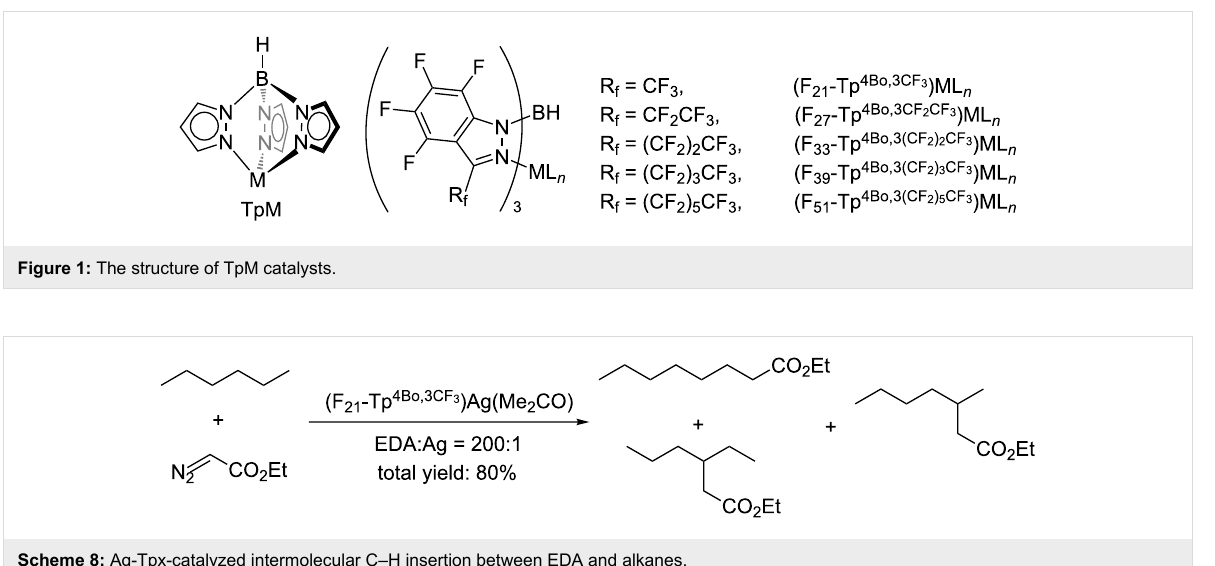
Scheme 8: Ag-Tpx-catalyzed intermolecular C–H insertion between EDA and alkanes.